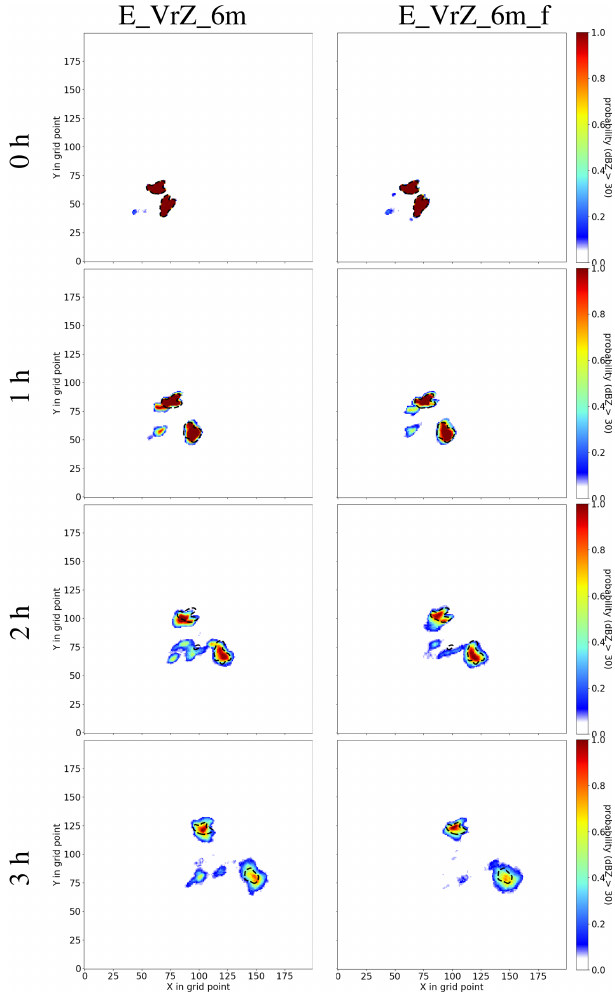
Figure 10. Ensemble forecasts (starting at 15:00UTC) of E_VrZ_6m (left) and E_VrZ_6m_f (right) based on the grid-point-based probabil- ities of ensemble members with a reflectivity composite at elevation 0 . 5 ◦ exceeding the threshold value of 30dBZ. Reflectivity ≥ 30dBZ in the nature run is denoted with dashed contour lines. The forecasts at the initial times of 1, 2 and 3h are presented from top to bottom.